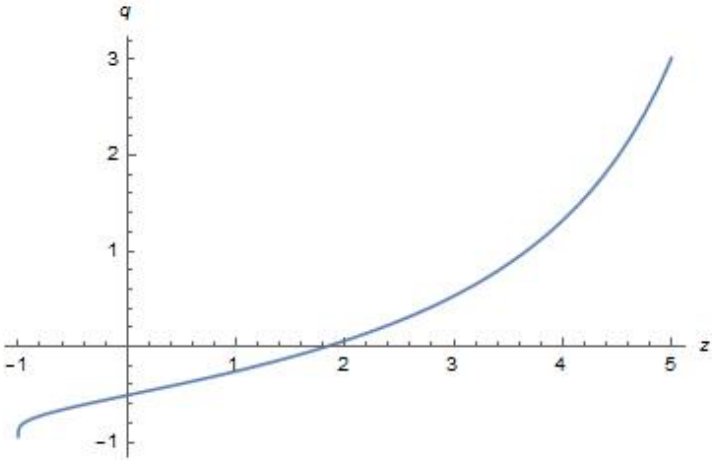
Figure 7. Deceleration parameter q against redshift z .